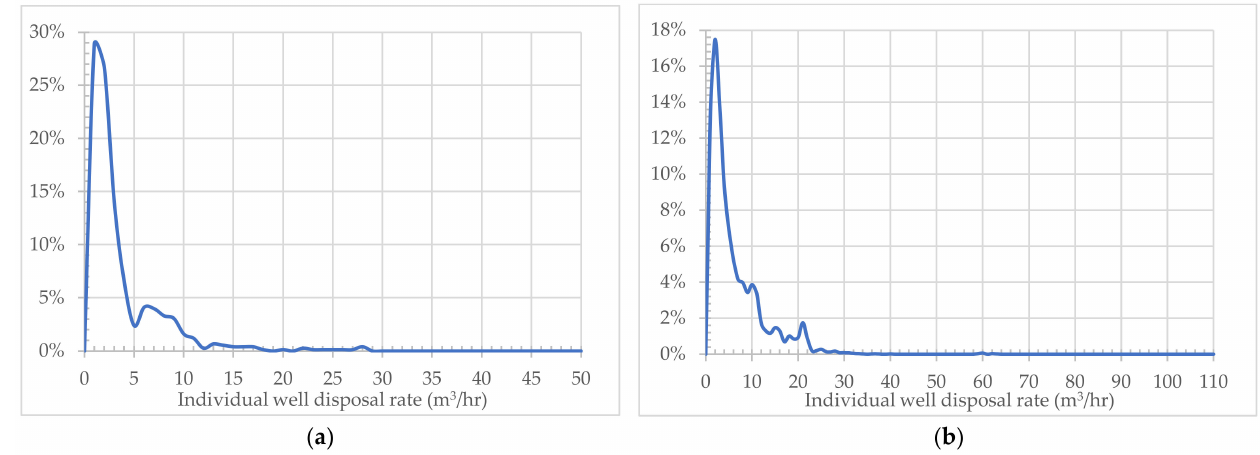
Figure A23. Historical per-well water injection rate ( X -axis) frequency ( Y -axis) distributions (January 1962–December 2022) in ( a ) the Shunda Formation; ( b ) the Pekisko Formation.